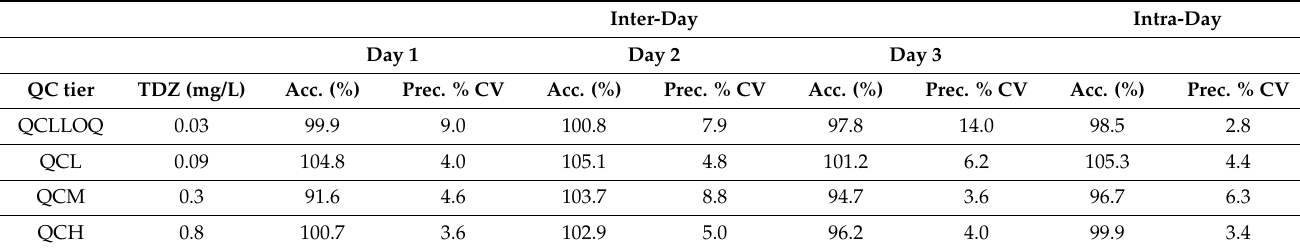
Table 1. Intra-day ( n = 5) and inter-day ( n = 15) accuracy and precision of QC samples for the validation of the HPLC method for the quantification of TZD in Meuller-Hinton Broth (MHB) bacterial growth medium with accuracy (Acc.) and precision